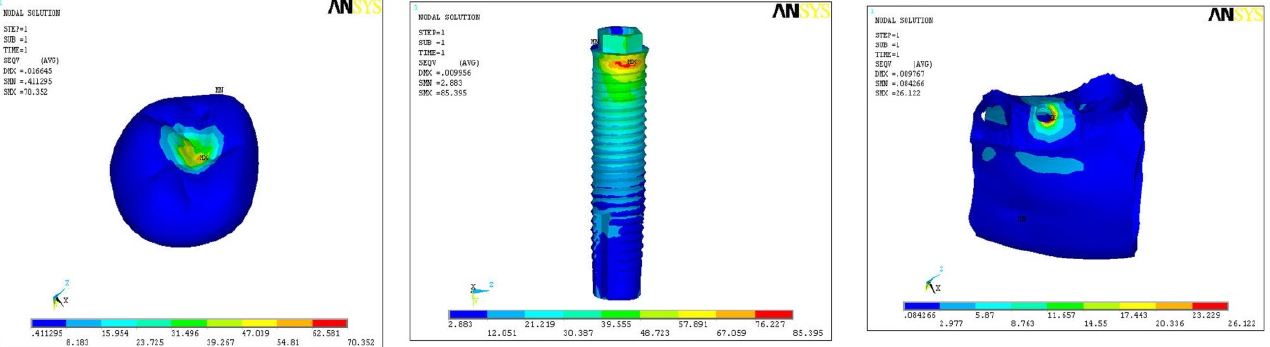
Figure 2. Pattern of stress in model A1.